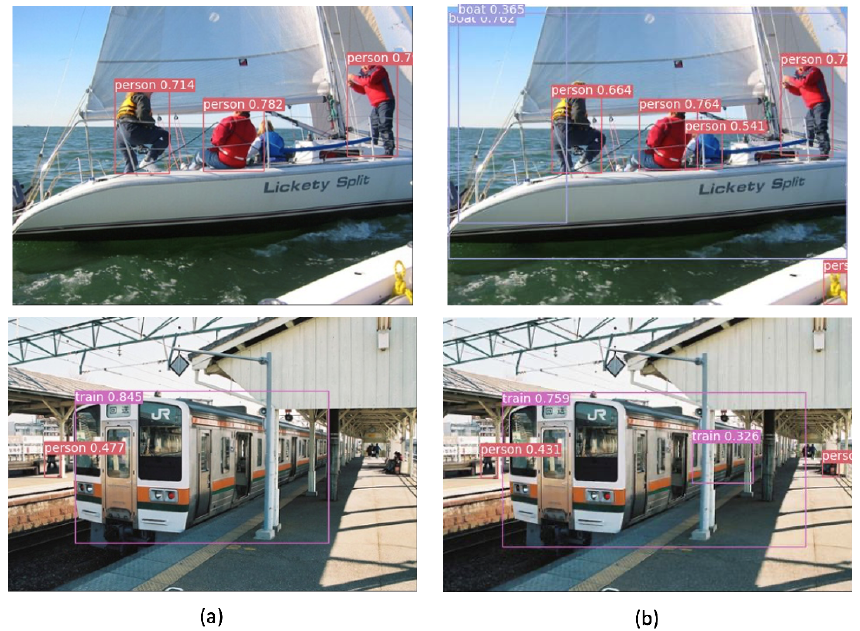
Figure 7. Detection results of ( a ) the conventional FCOS and ( b ) proposed method for the PASCAL VOC 2007 test